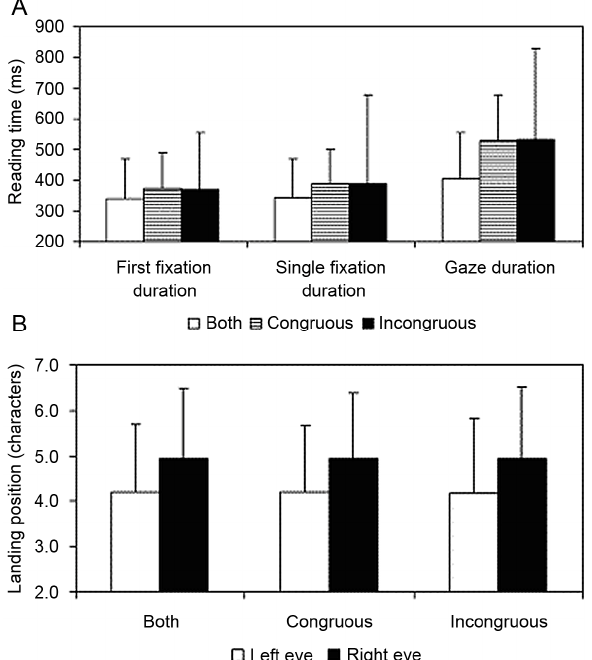
Figure 3. Mean Reading Times and Saccade Landing Positions on the Target Word for Each Condition. (A) Mean reading times (+1 standard deviation) for the target word under congruent and incongruent dichoptic viewing conditions, and the control condition where the whole word was presented to both eyes. First fixation duration is the duration of the first fixation on the word, regardless of whether the word was refixated. Single fixation duration is the duration of the first fixation on the word contingent on the participant not refixating the word. Gaze duration is the sum of all the fixations on the word until the participant made a saccade to another word. (B) Mean saccadic landing positions (+1 standard deviation) on the target word for the left eye and the right eye under congruent and incongruent dichoptic viewing conditions, and the control condition where the whole word was presented to both